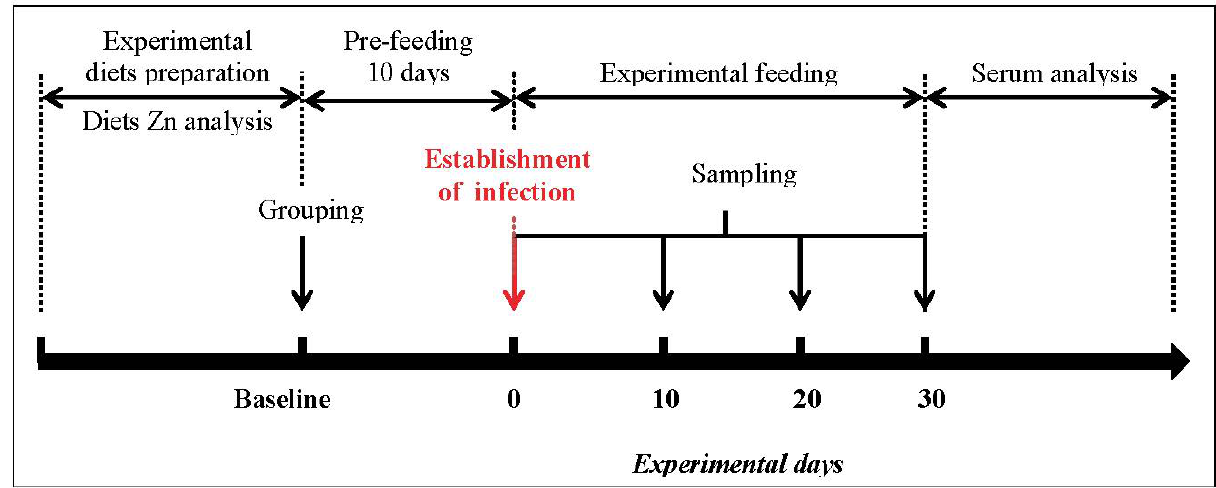
Figure 1. Experimental protocol used in the present